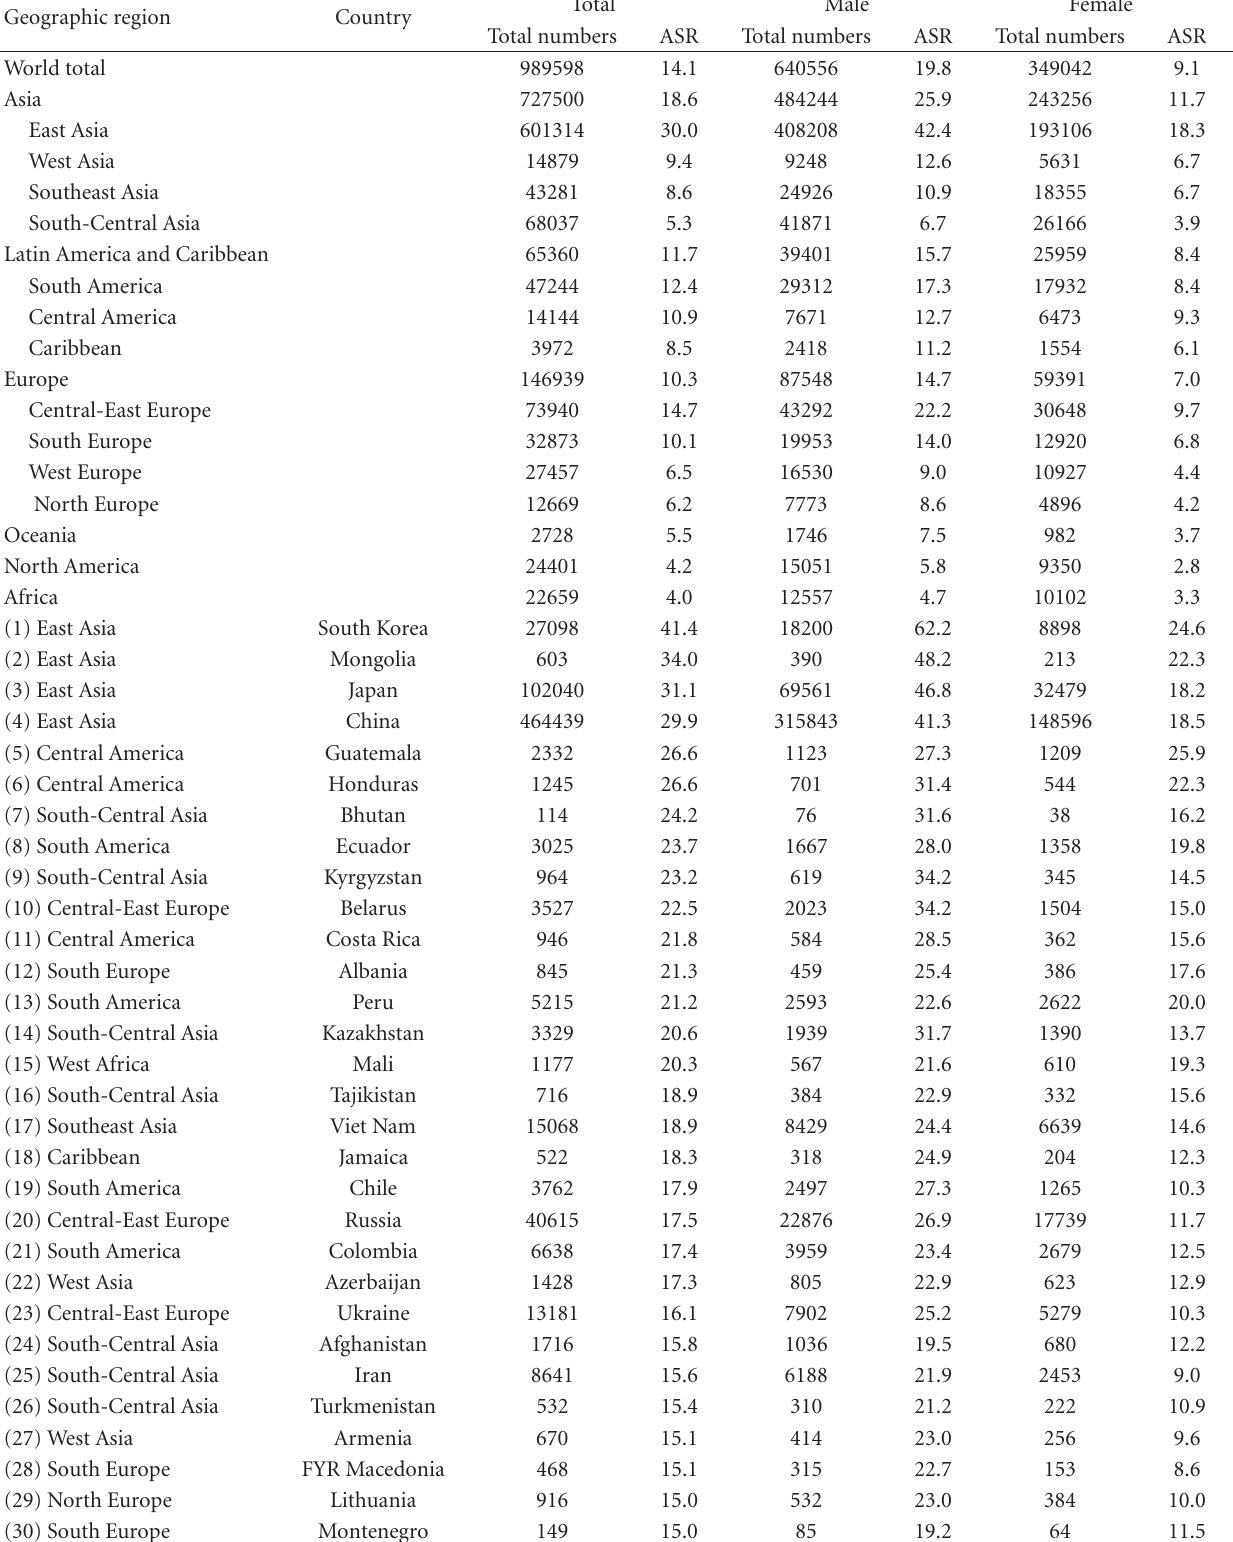
Table 1: Incidence of gastric cancer in